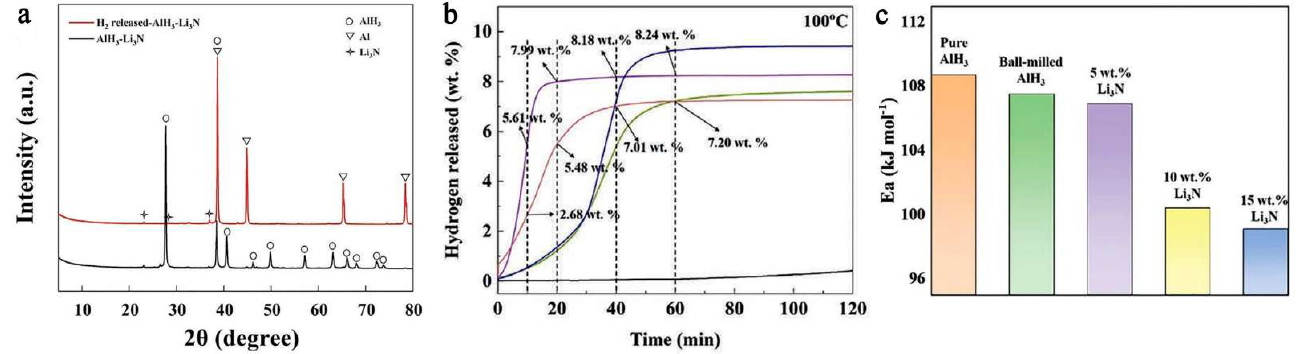
Figure 19. The XRD pattern (0.9AlH 3 -0.1Li 3 N) dehydrog ( a ), the hydrogen release profile under isother- mal conditions (100 °C) of (1 − x)AlH 3 -xLi 3 N (x = 0, 0.05, 0.1, 0.15) ( b ), and the calculated apparent activation energy ( c ). Reprinted/adapted with permission from Ref. [206]. 2022, Wiley-VCH GmbH.